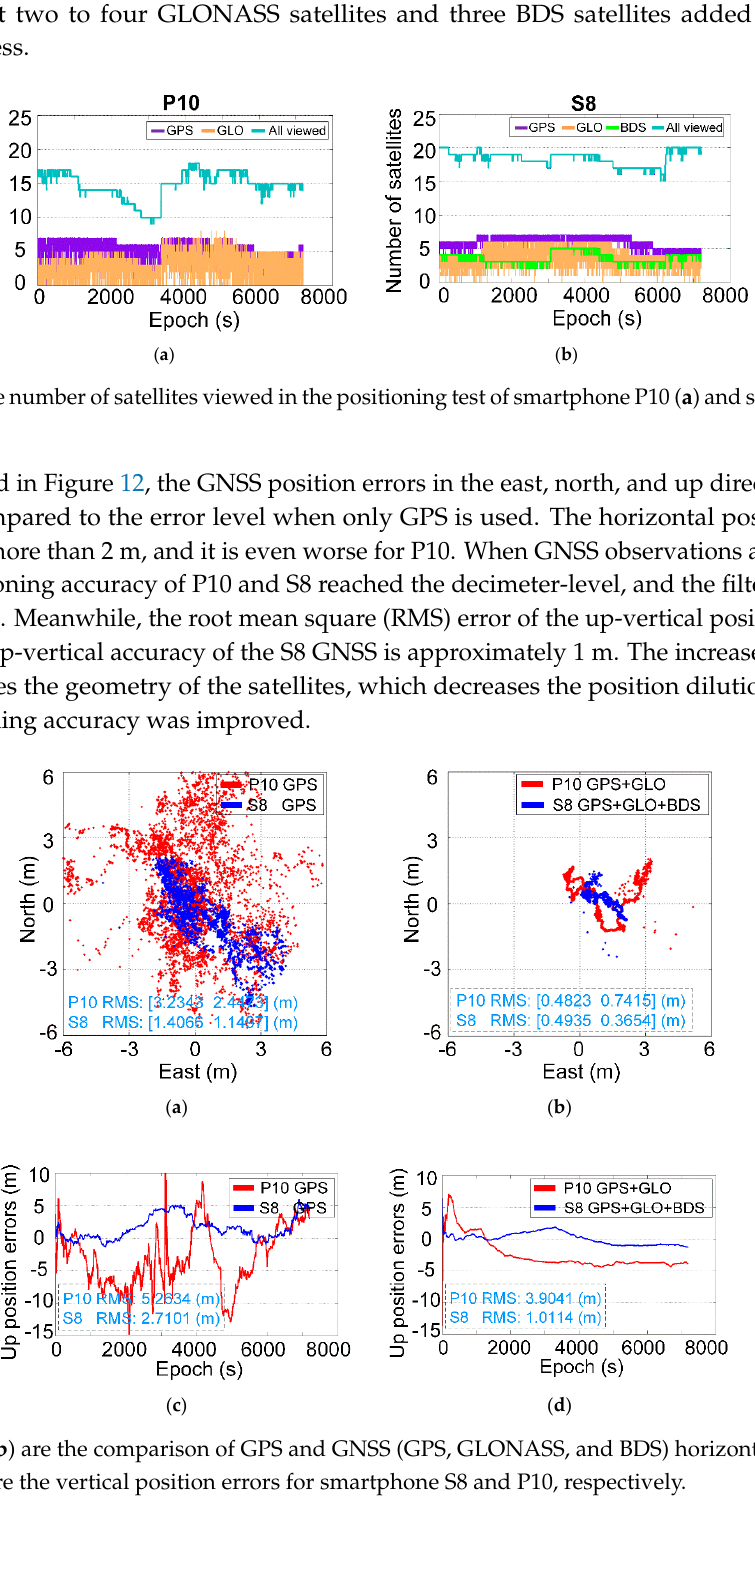
Figure 10. Allan standard deviation (STD) value of accelerometer ( a ), gyroscope ( b ), and magnetometer ( c ) data.